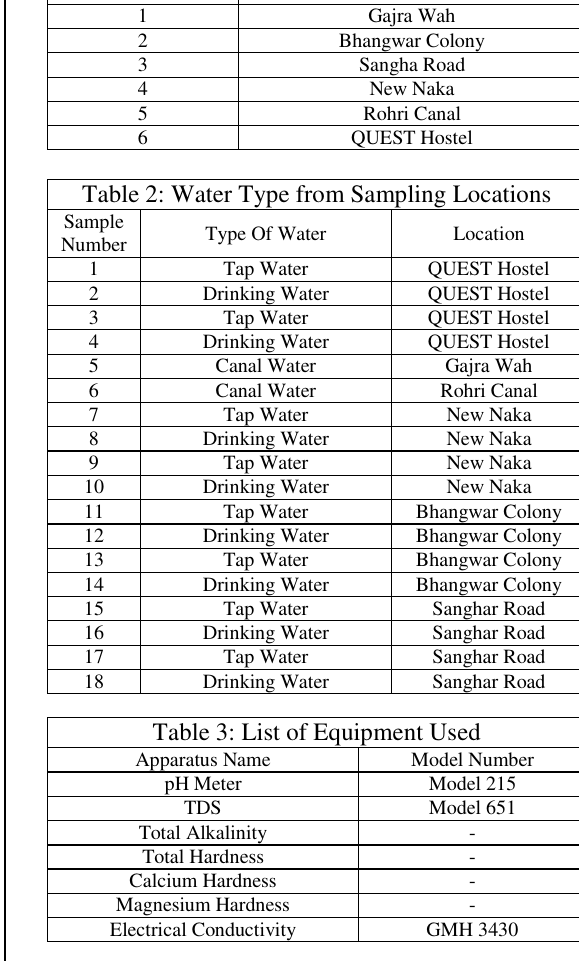
Table 3: List of Equipment